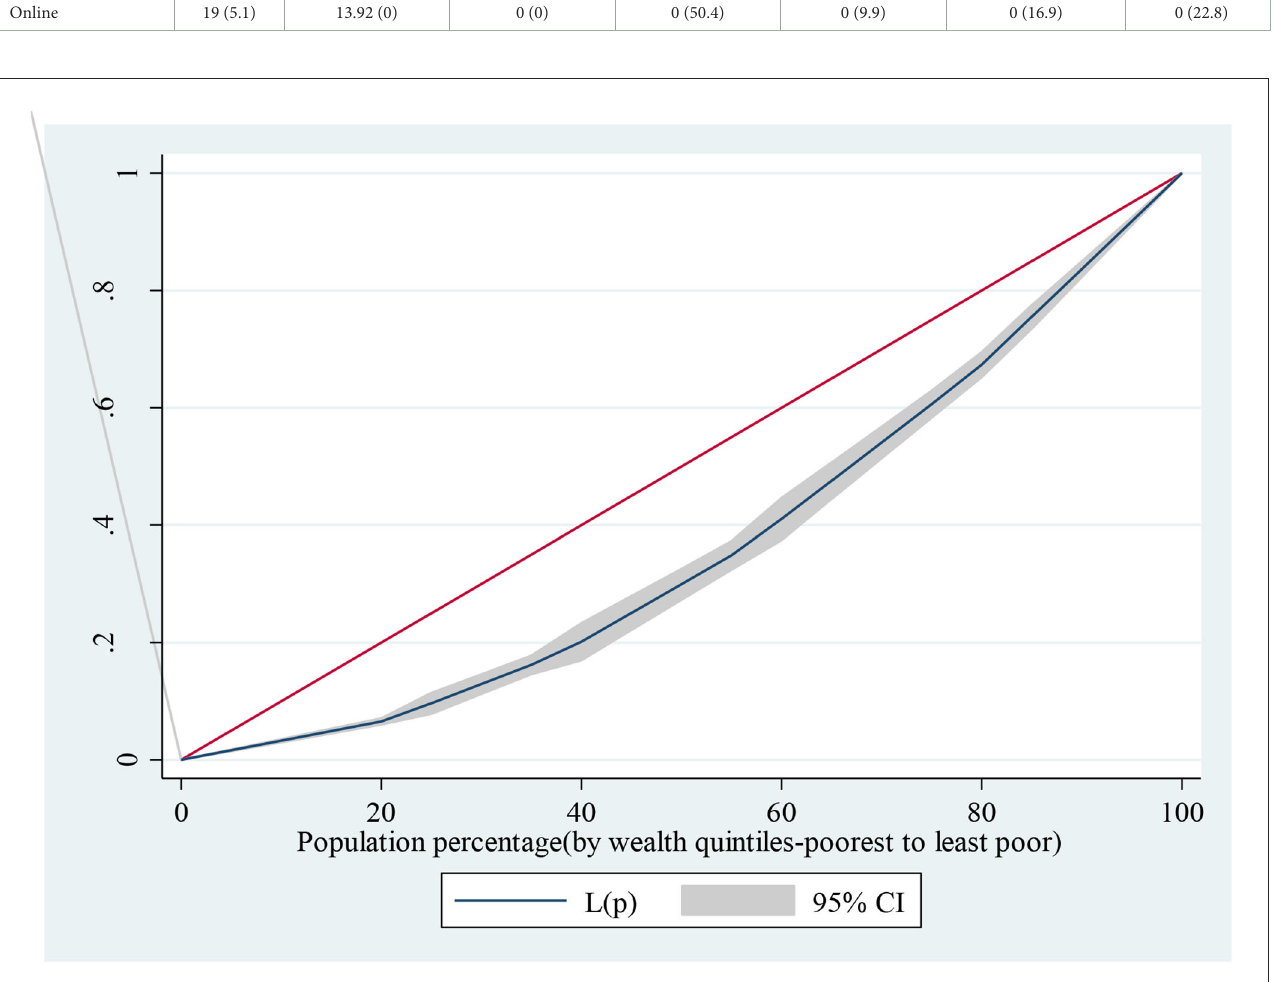
FIGURE1 Wealth inequality among individuals who achieved dietary diversity.